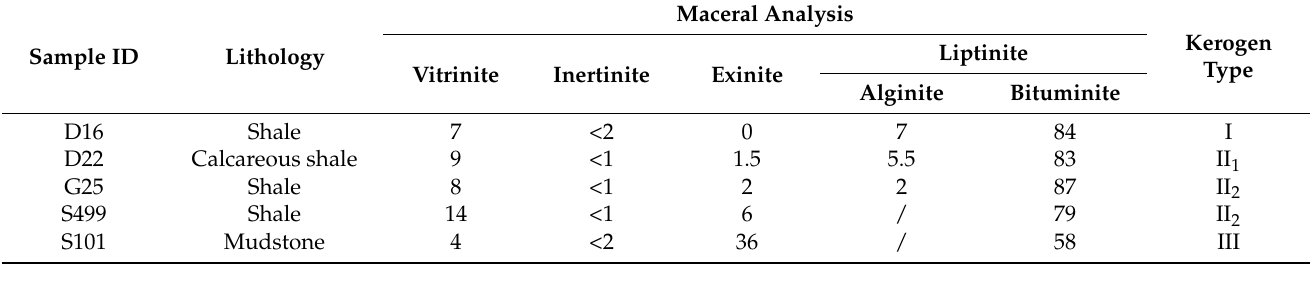
Table 2. Maceral groups of simulated samples.